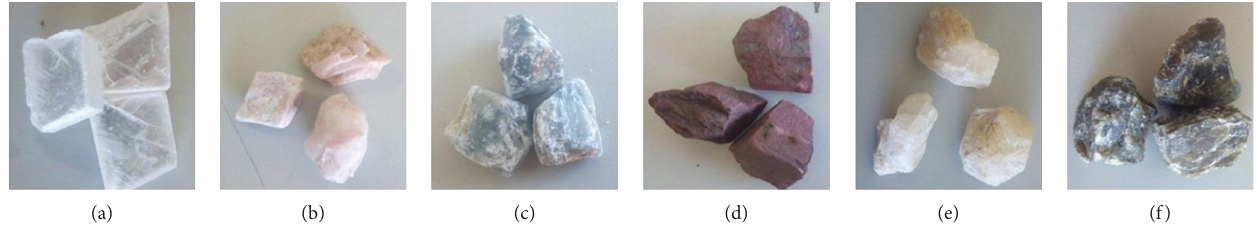
Figure 2: Some geological samples used in this study: (a) selenite, (b) spodumene, (c) barite, (d) hematite, (e) moonstone, and (f) labradorite.